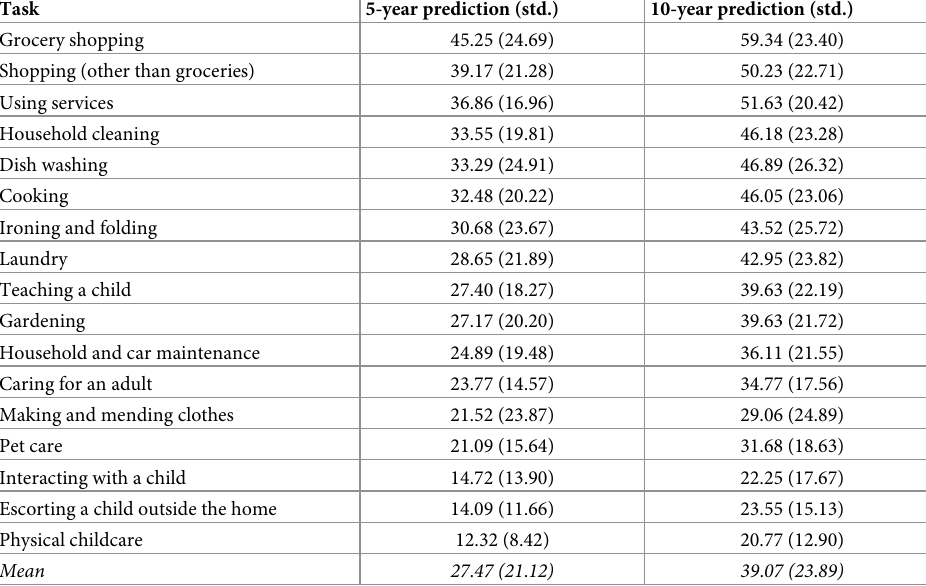
Table 2. Estimated automatability of domestic work tasks (% of time